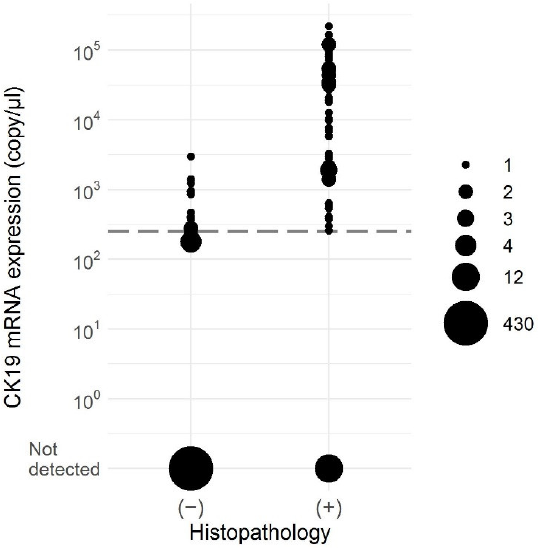
Figure 2. CK19 mRNA expression in SLNs ( n = 534) revealed by OSNA analysis according to histopathological examination. The dotted line depicts the 250 copies/µL cut off value.